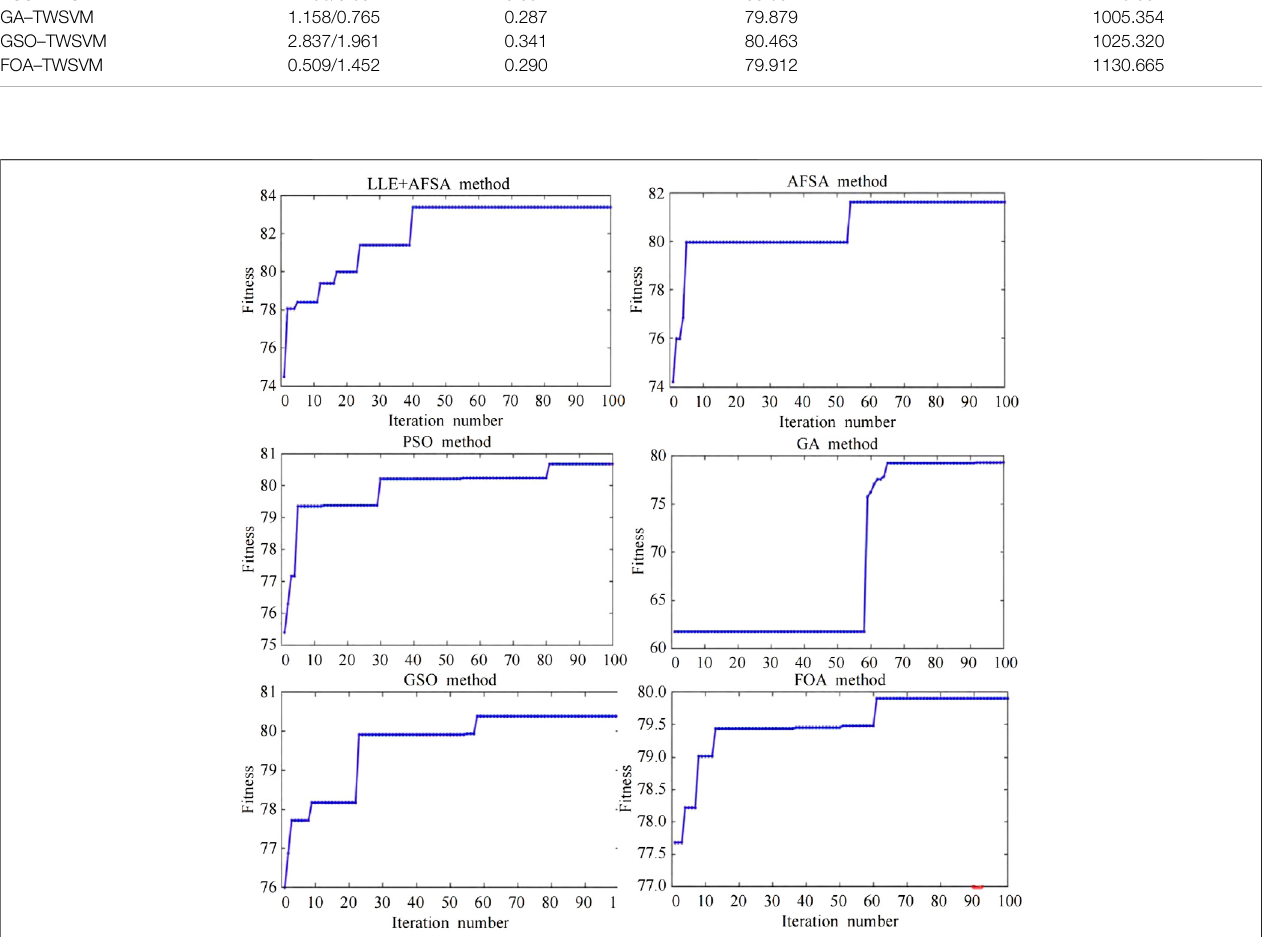
FIGURE 5 | Optimization process curve of different algorithm